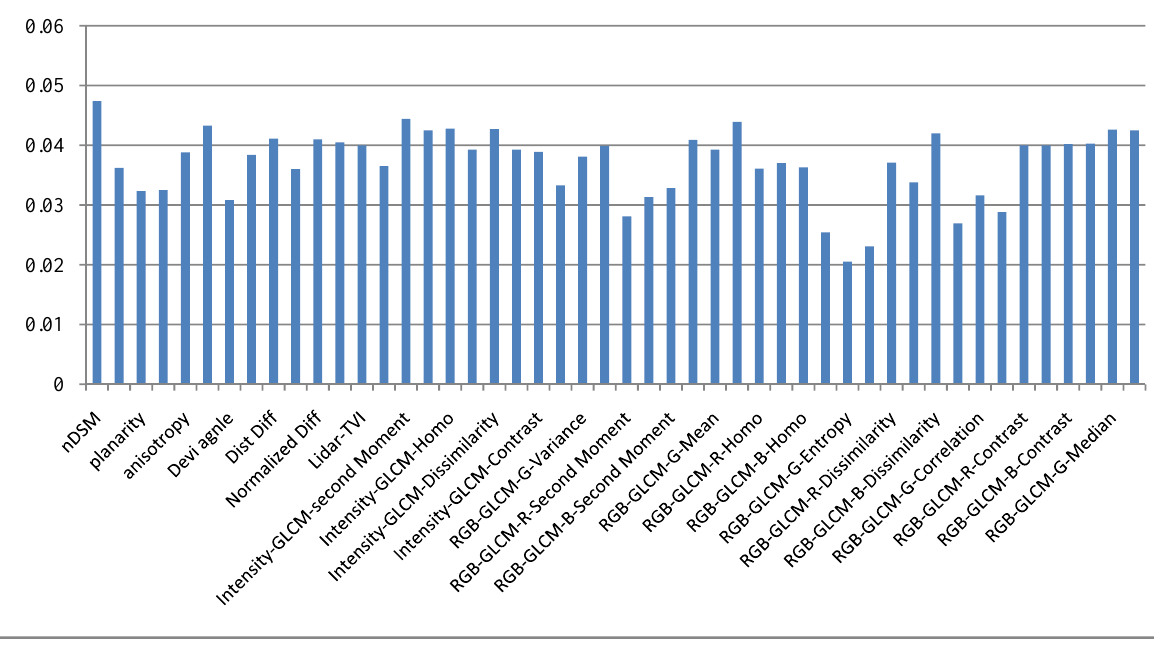
Figure 3. Random Forests-based feature importance